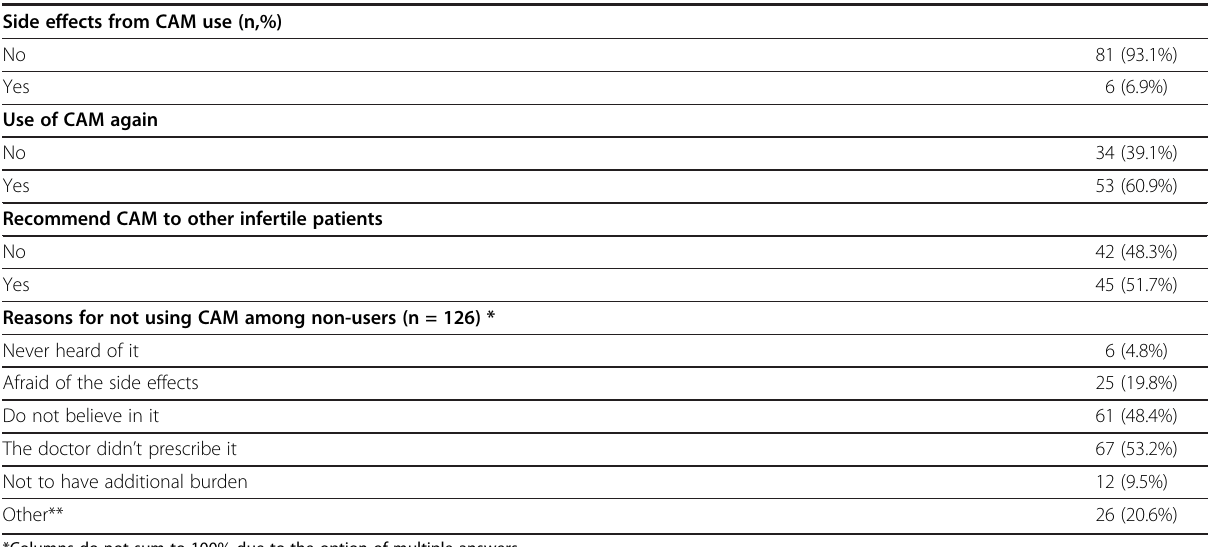
Table 2 Types and modes of CAM use among couples seeking infertility treatment (n = 87) (Continued) Side effects from CAM use